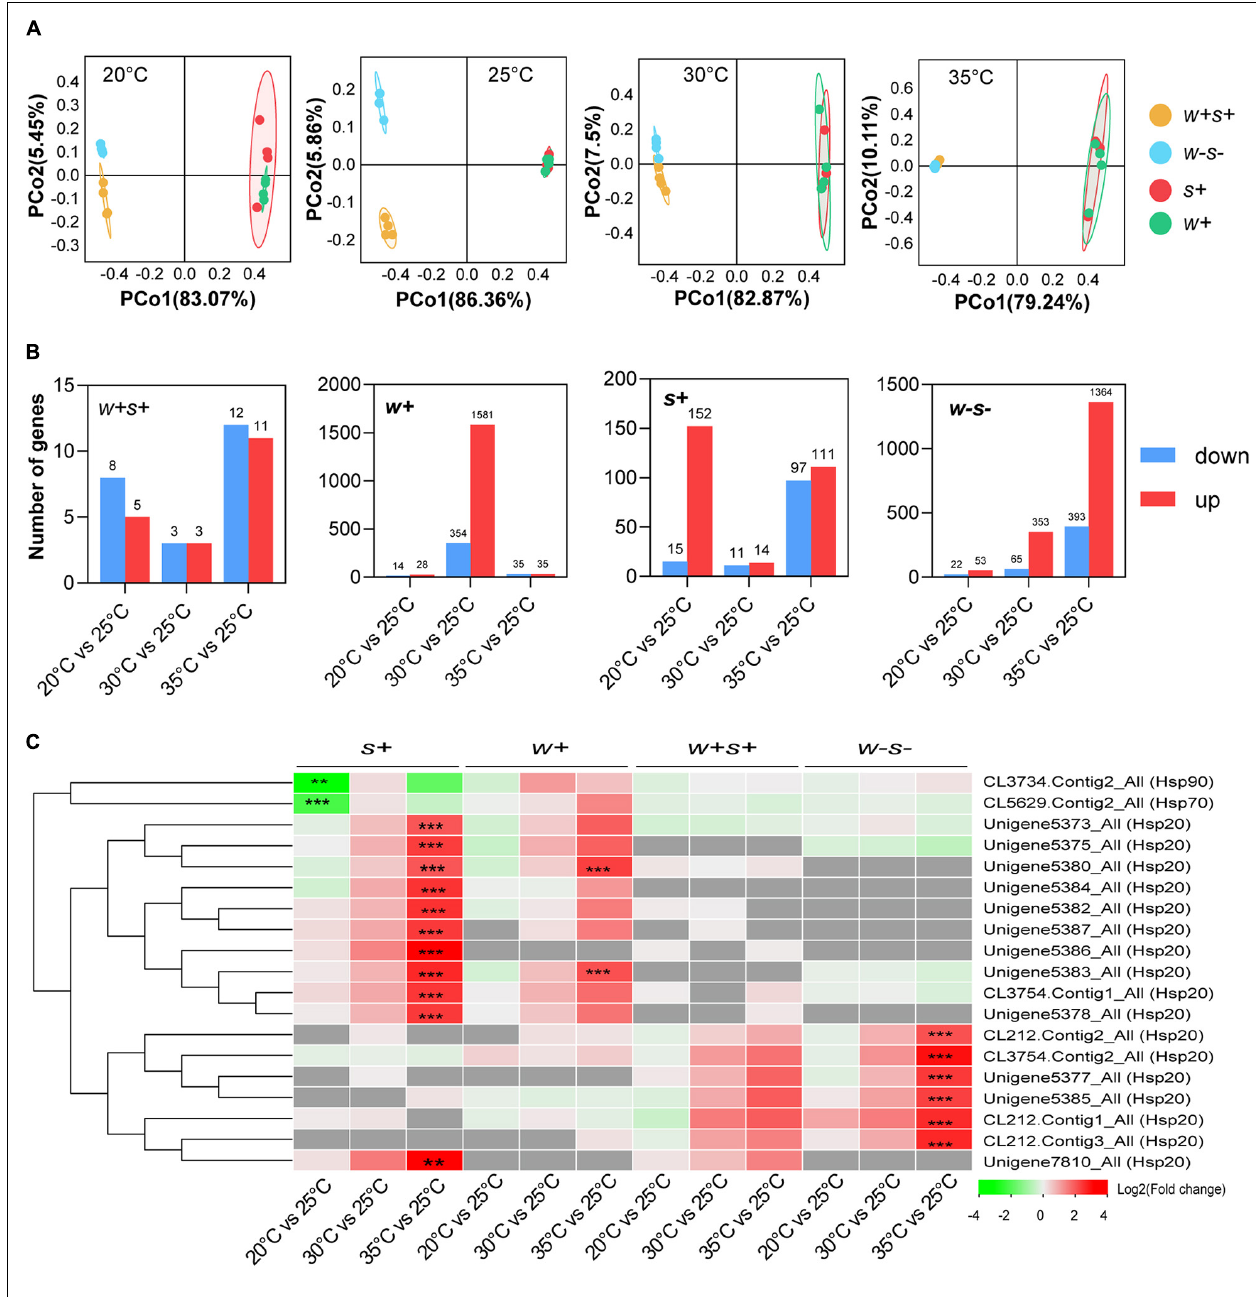
and gradual loss occurred at 28 ◦ C (Anbutsu et al.,